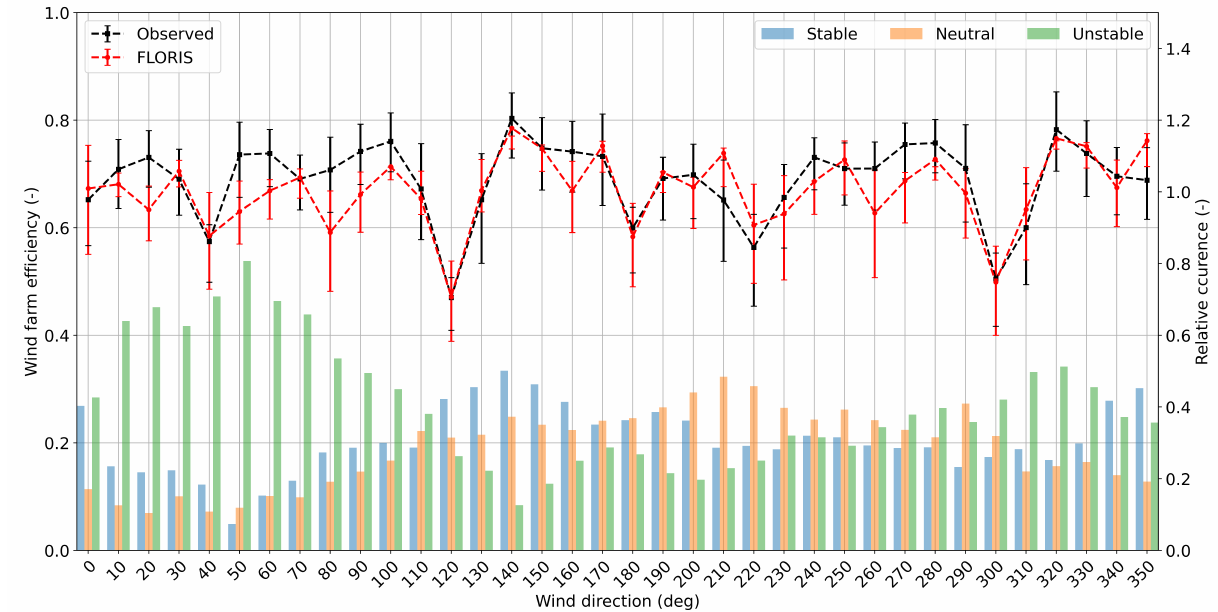
Figure 10. The wind farm efficiency for each wind direction bin where the errorbars indicate the 25th and 75th quartiles in both observed and modeled values. The stability distribution per wind direction bin is also